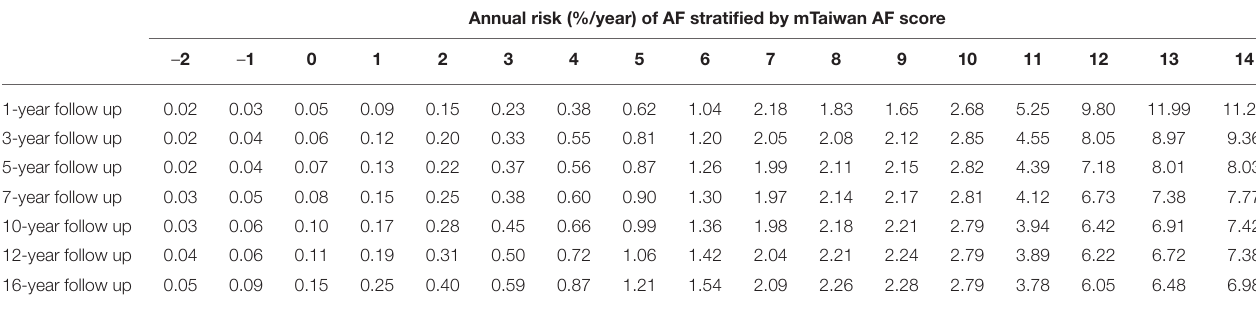
TABLE 3 | Incidence of AF stratified by mTaiwan AF score after different follow-up